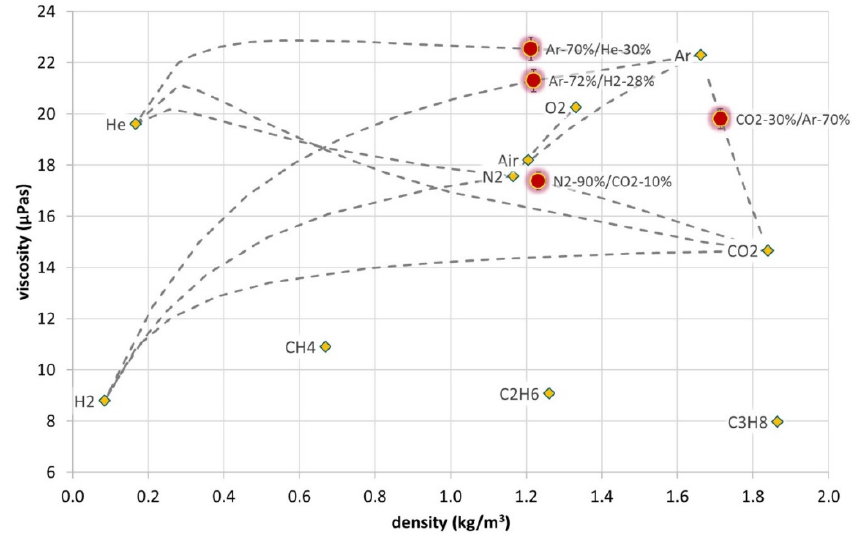
Figure 11. Estimation of the binary gas composition from density and viscosity values given by the sensor model described in Appendix A.1. and the NIST Refprop Database [19].